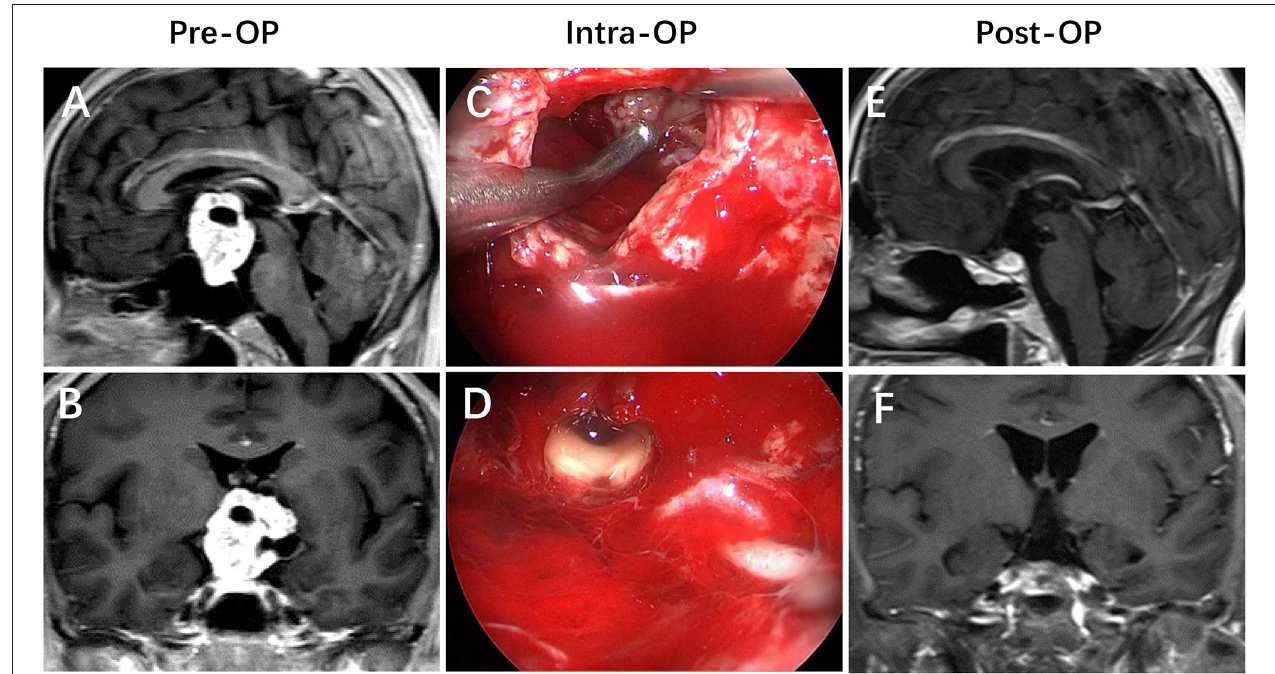
FIGURE 4 | Craniopharyngioma with a large volume. (A,B) Preoperative enhanced MRI demonstrated that a giant suprasellar mass developed from the pituitary stalk that pushed the TVF upward, mimicking an intraventricular position. (C,D) Intraoperative views revealed that the patient achieved a gross-total resection of the lesion via the endonasal endoscopic endonasal infrachiasmatic corridor. (E,F) Postoperative enhanced MRI revealed that the lesion was totally removed, with the TVF